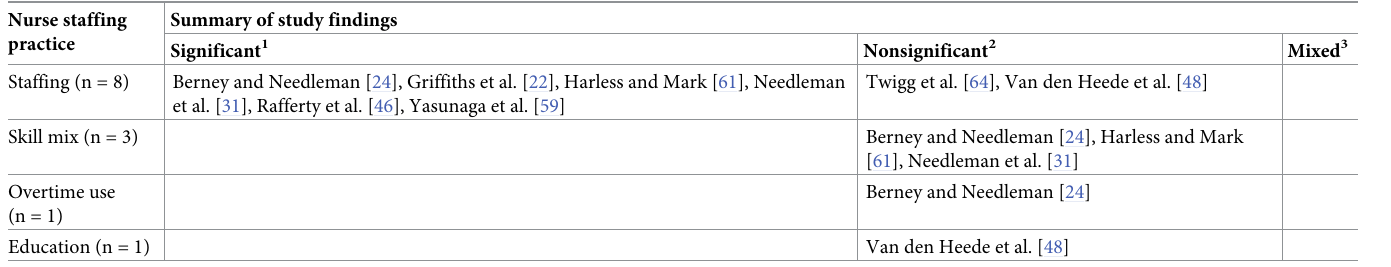
Table 5. Nurse staffing practices in association with in-hospital failure-to-rescue.